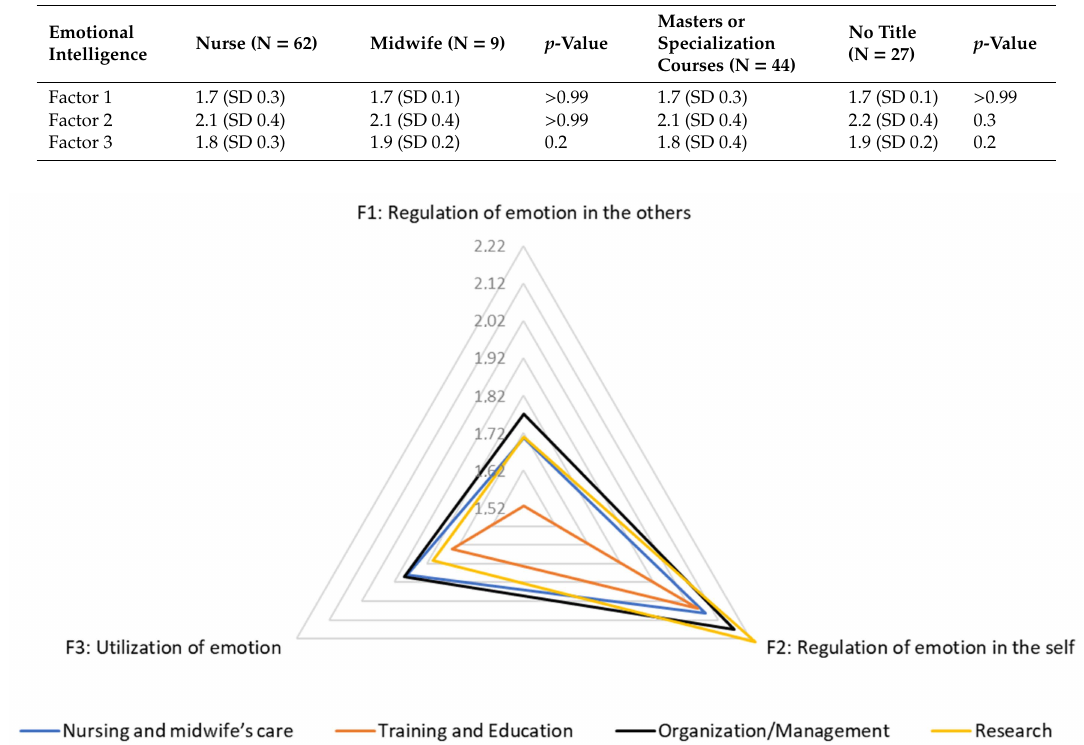
Table 7. Mean, standard deviation and p -value (Student’s t -test) of sample’s EI factors score, stratified by professional qualification and postgraduate training.